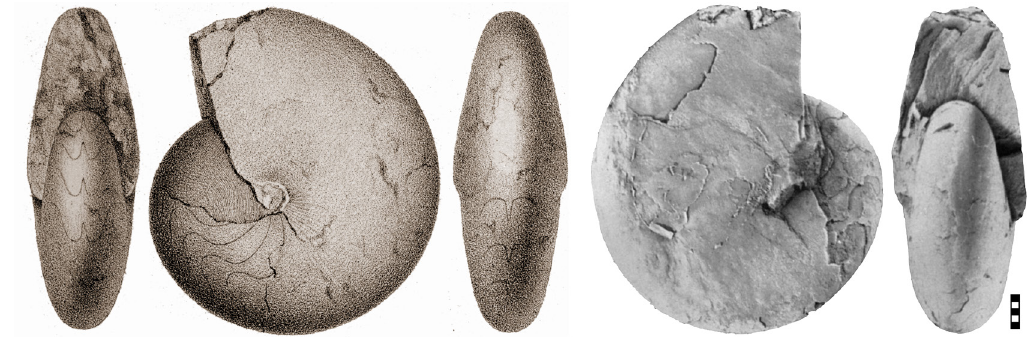
Fig. 4. Tornoceras typus (Sandberger & Sandberger, 1851), reproduction of the lectotype illustrations by Sandberger & Sandberger (1850–1856, pl. 10 fig. 14) and the photography by M.R. House in Becker (1993, pl. 3 figs 1–2). Scale bar units = 1